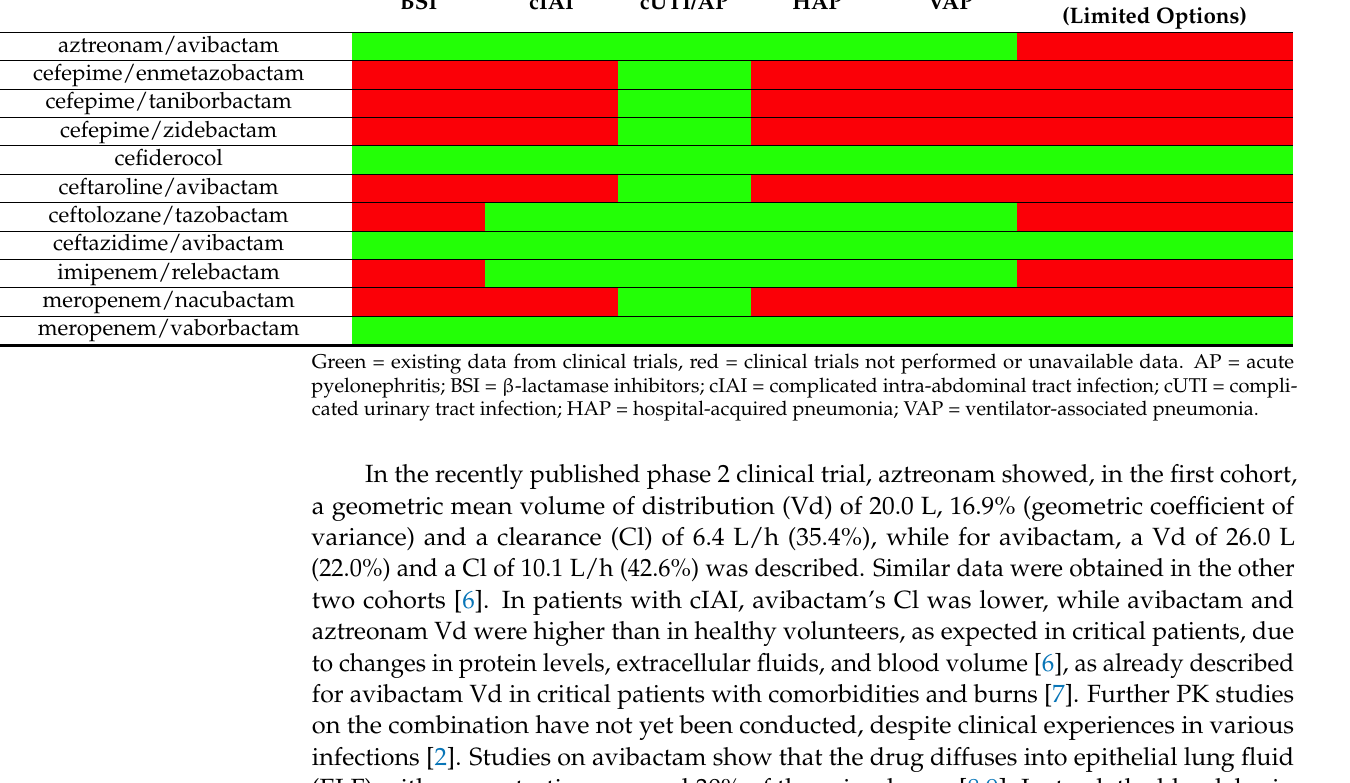
Table 2. Clinical settings investigated or under investigation for each compound. BSI cIAI cUTI/AP HAP VAP